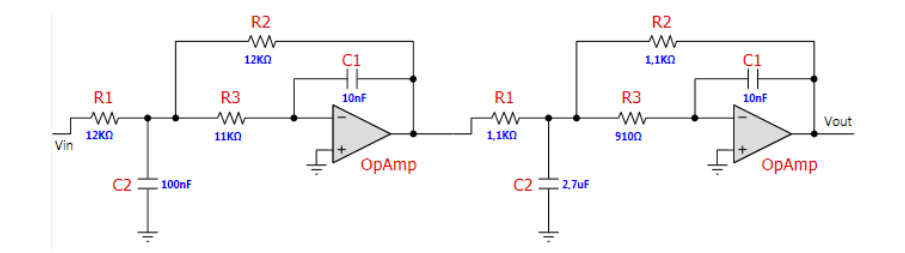
Fig. 4. The output of FilterPro utility by Texas